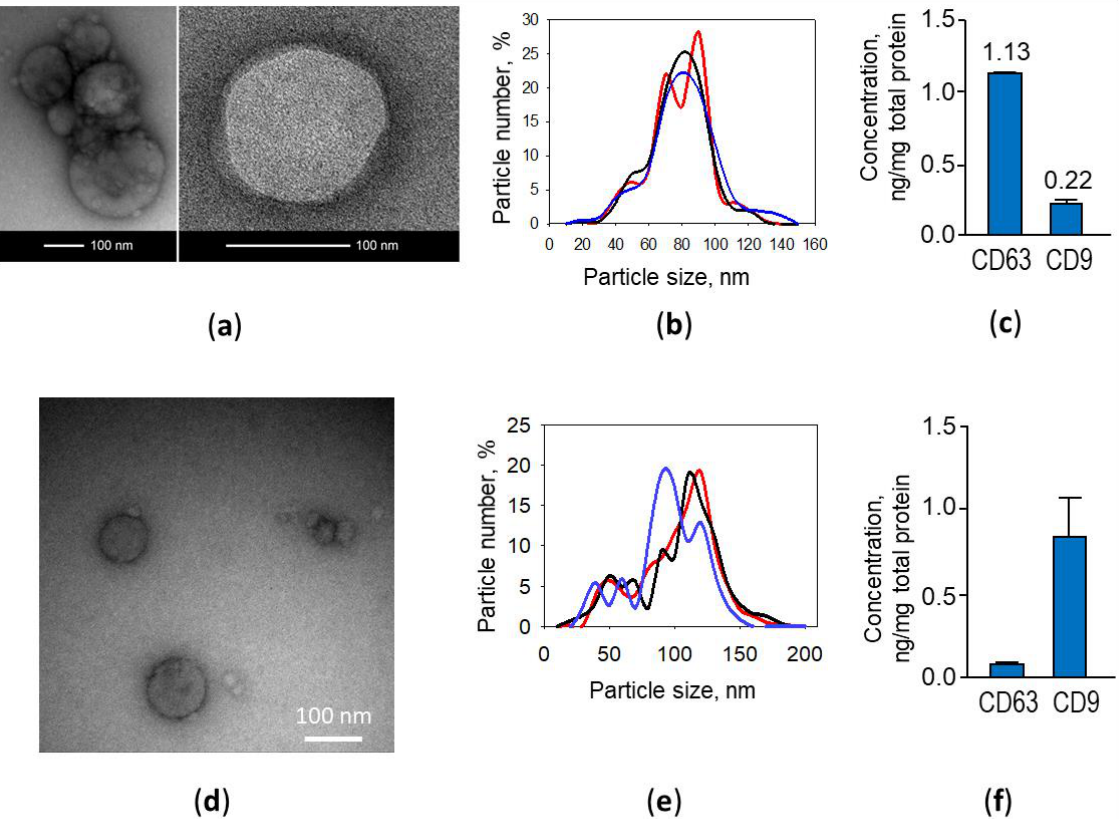
Figure 2. Poly (I:C)-treated rat ( a – c ) and mouse ( d – f ) airway cell ELV morphology, particle size distribution and specific markers. Representative transmission electron microscopy images ( a , d ), dynamic light scattering nanoparticle analysis data of three exosome samples ( b , e ) and tetraspanin CD63 and CD9 content per total exosome preparation protein determined by ELISA ( c , f ).